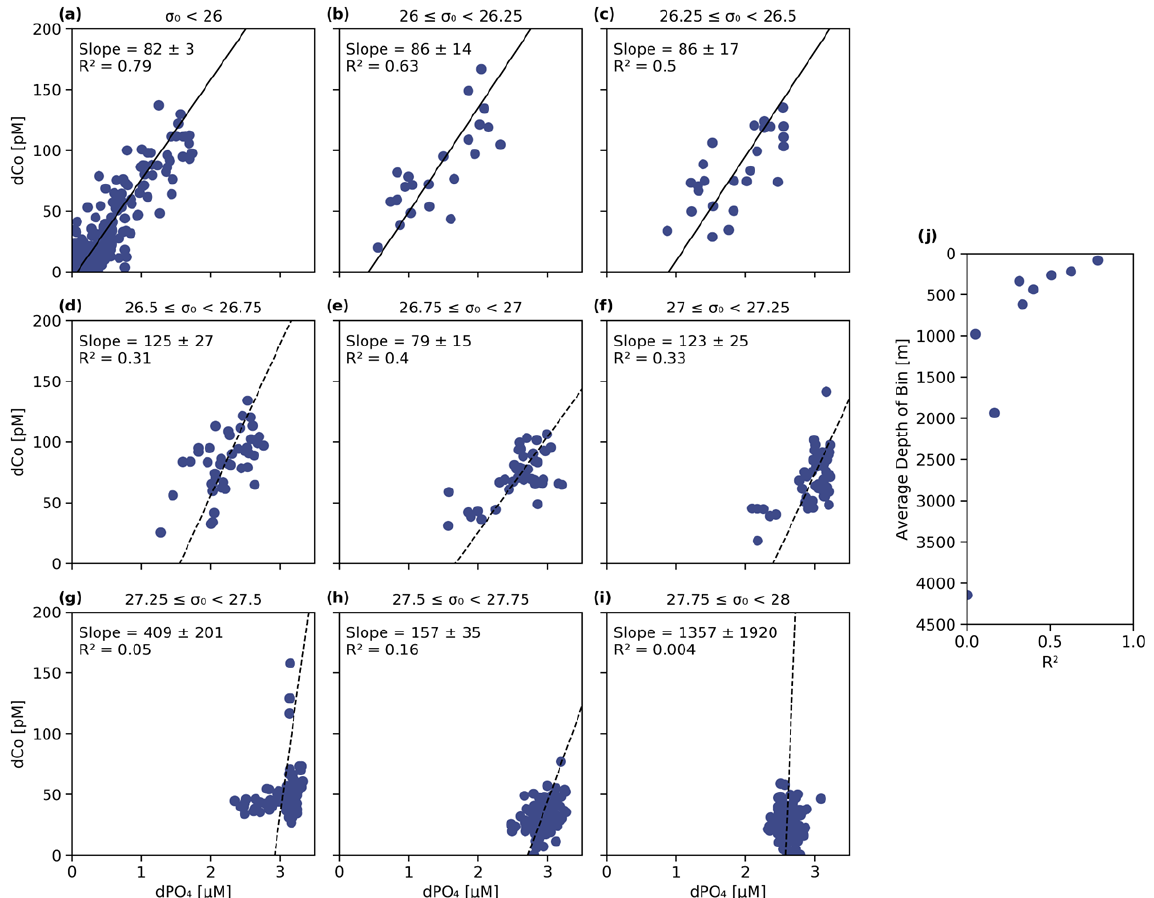
Figure 9. (a–i) The dCo vs. dPO 4 relationship sorted into nine isopycnal bins by potential density ( σ 0 ) with a linear best-fit trend line. The least dense samples (a) represent the surface ocean and phytoplankton dCo:dPO 4 nutrient ratio (82 ± 3, µmol:mol; n = 218, R 2 = 0.79). The decreasing R 2 (j) in denser isopycnal bins represents the decoupling of dCo and dPO 4 at depth and increasing relevance of Co scavenging. Samples with [dCo] > 200pM and Stations 1 and 2 have been omitted from this